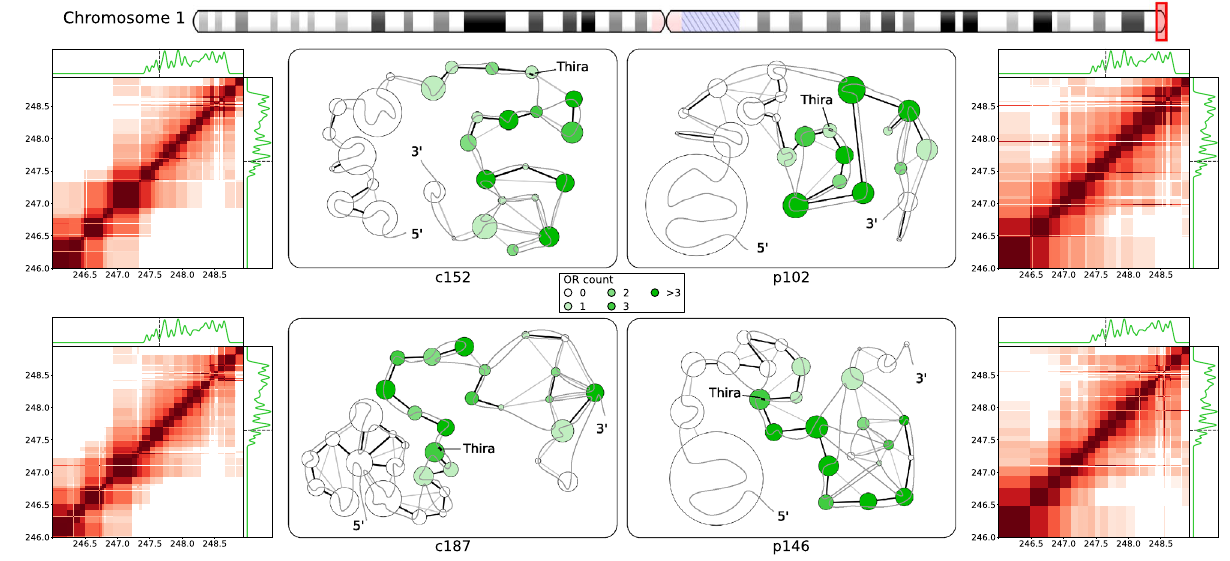
Figure 5. Fine structural organization in a Class II olfactory receptor gene cluster near the chromosome 1 q-ter telomere. Notations and marks are as in Fig. 4. Heatmaps of interactions and network representation are given for structural units in the 246.00–248.94 Mb region of chromosome 1. Structural units are indicated by dark red squares along the diagonal, and off-diagonal-colored regions show interactions with energy ratios above a threshold, r > 0.05. The distribution of Class II OR genes is indicated by the adjoining 1D plots by the green traces, and the location of the PE Thira is marked by the black dashed line. Network representation of structural units in the OR cluster, with strong interactions indicated by black/grey edges, and the approximate location of the PE marked by a black